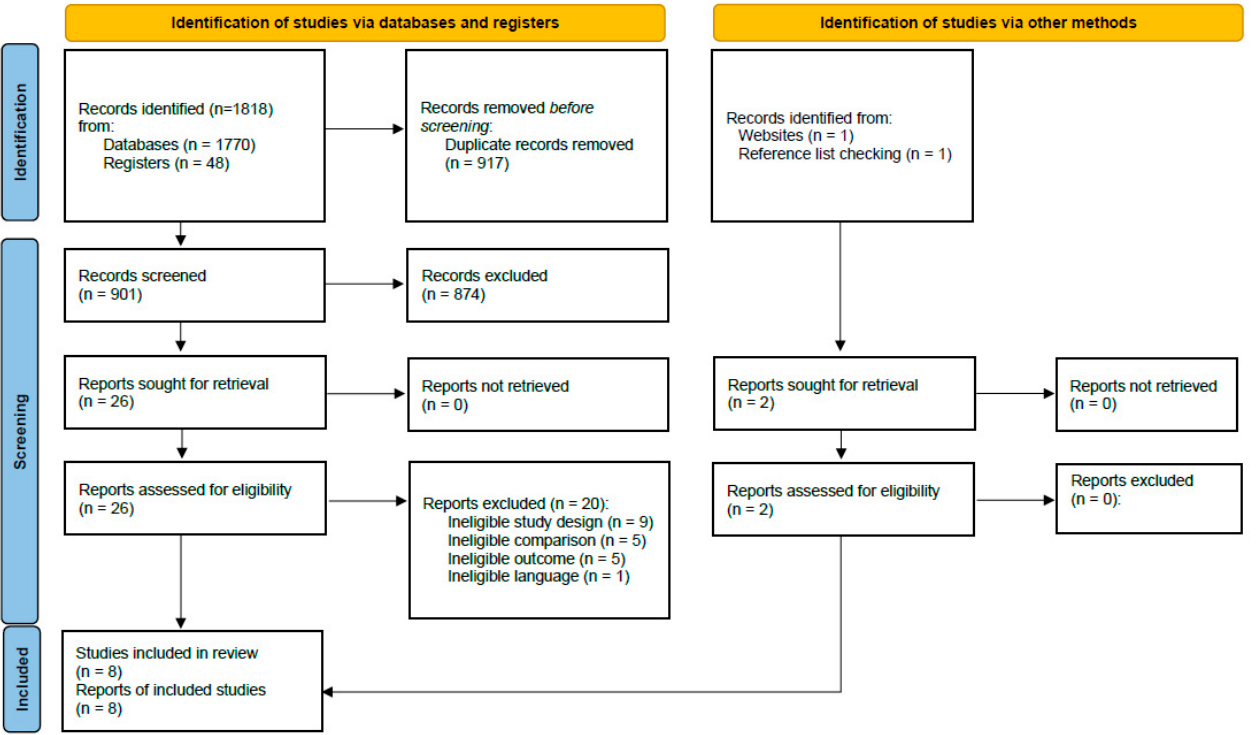
Figure 1. Preferred Reporting Items for Systematic Reviews and Meta-Analyses (PRISMA) flow-chart adapted from Page et al. 2021 [18].